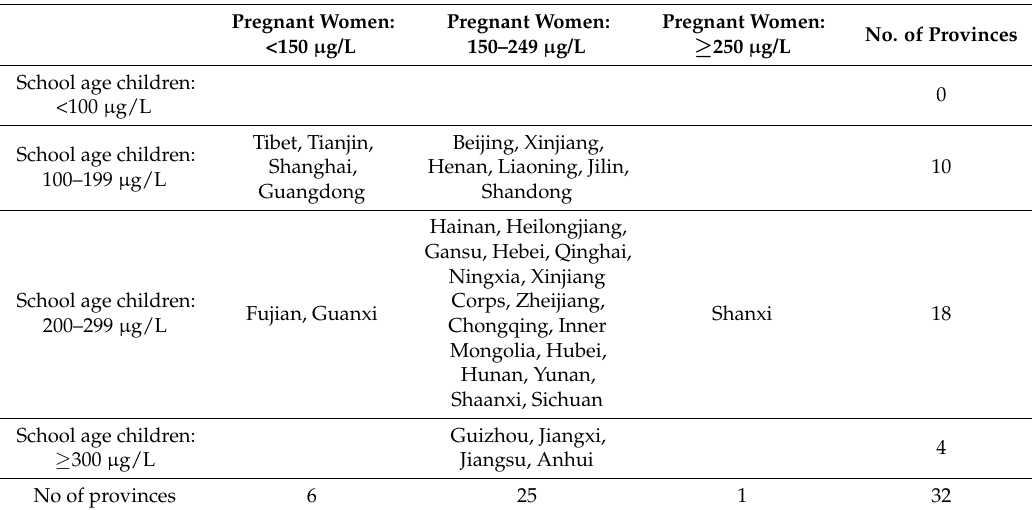
Table 4. Iodine status of school age children and pregnant women by province, 2011 National IDD Survey [31]. IDD, iodine deficiency